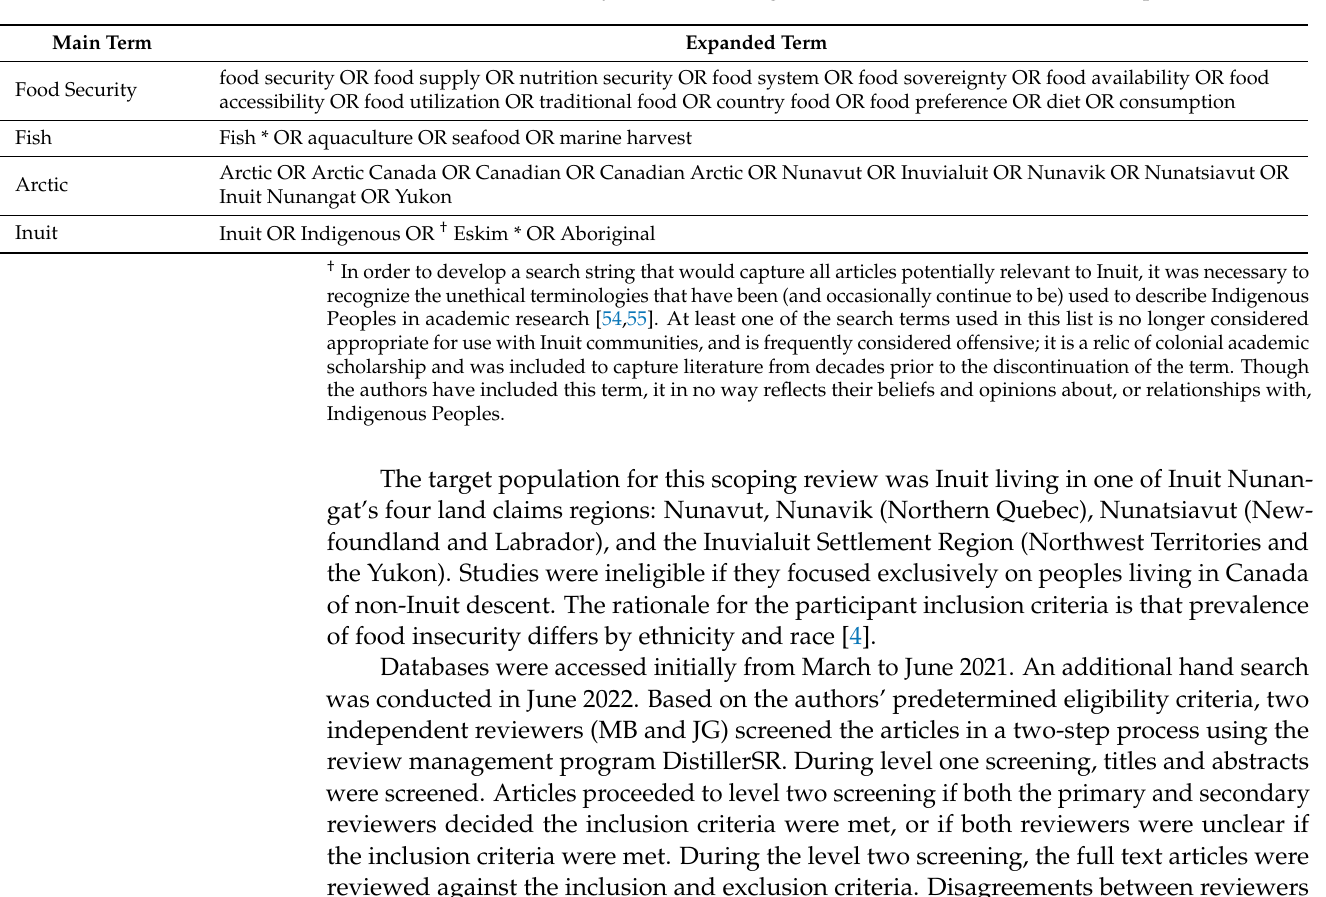
Table 1. Example search terms used in database searches to identify studies on the role of the fish and seafood on food security in Inuit Nunangat (* indicates a truncation Boolean